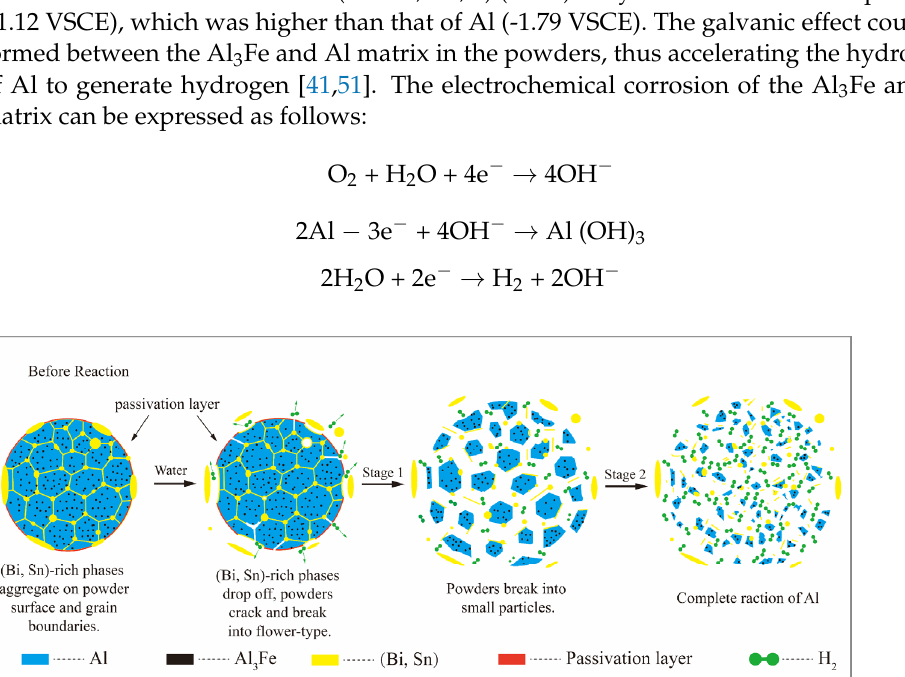
Figure 11. Hydrogen generation curves of the Al-10Bi-7Sn-1.5Fe (wt.%) composite powders exposed to air for different times reacting with 0.1 mol · L − 1 CaCl 2 solution at 50 ◦ C.